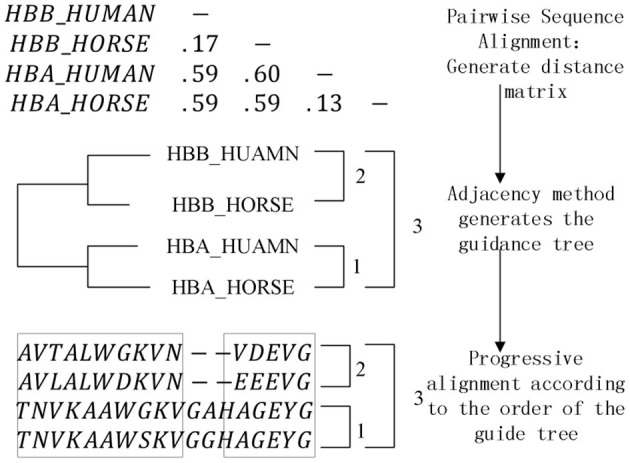
Steps of ClustalW.